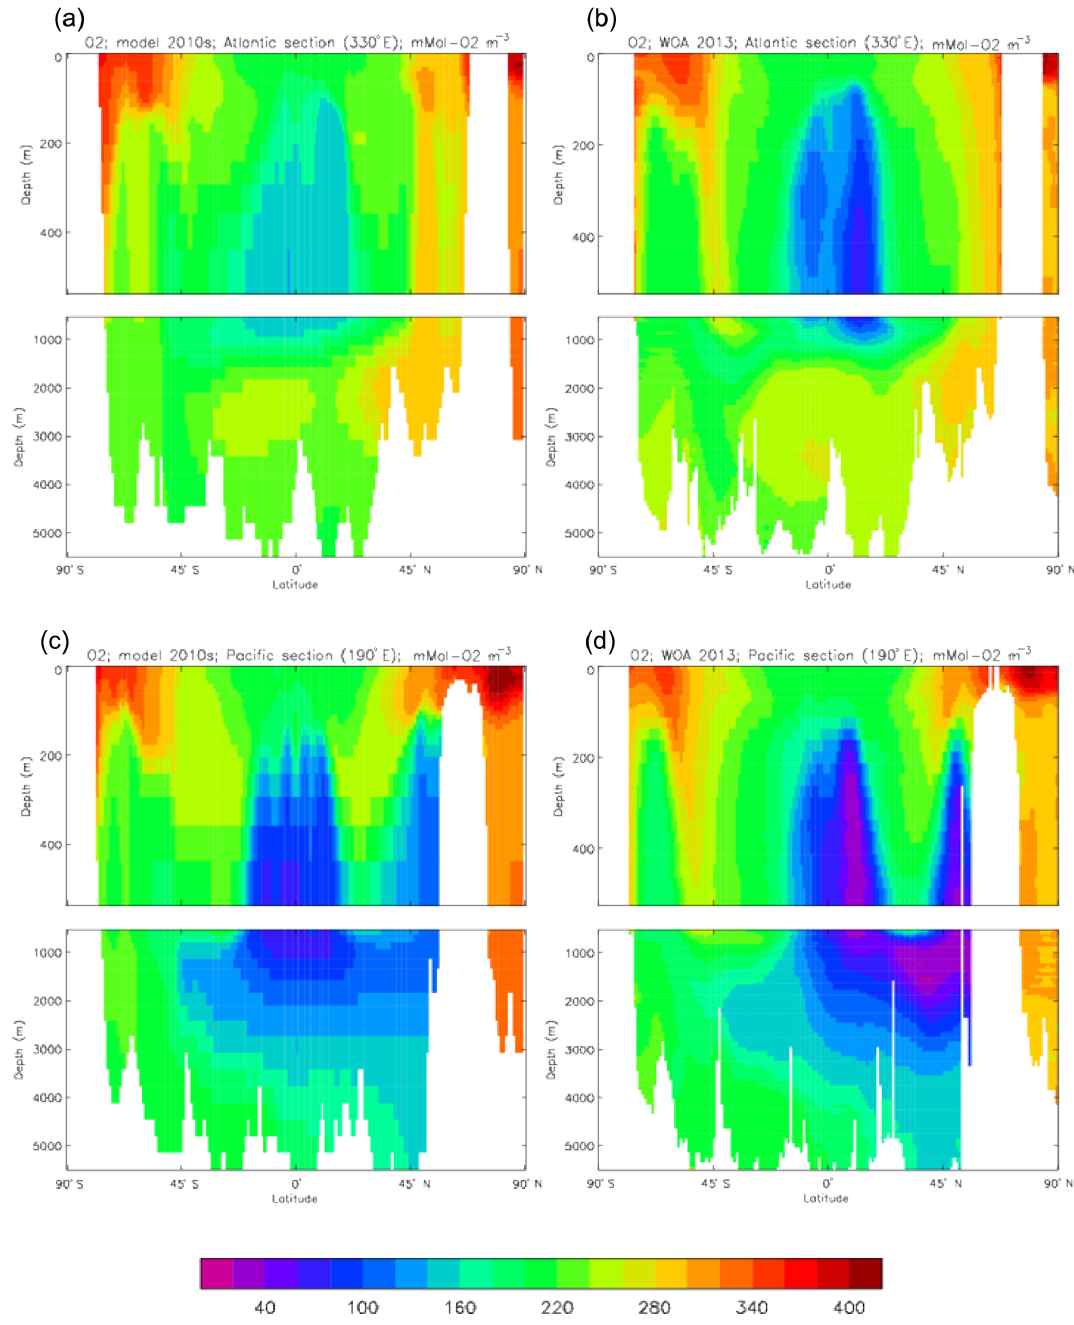
Figure 30. Meridional sections of dissolved oxygen (mMolO 2 m − 3 ): panels (a) and (b) show sections in the Atlantic Ocean along 330 ◦ ; (c, d) Pacific Ocean sections along 190 ◦ . Panels (a) and (c) show model concentrations averaged over 2010–2019; panels (b) and (d) show concentrations from the 2013 World Ocean Atlas gridded